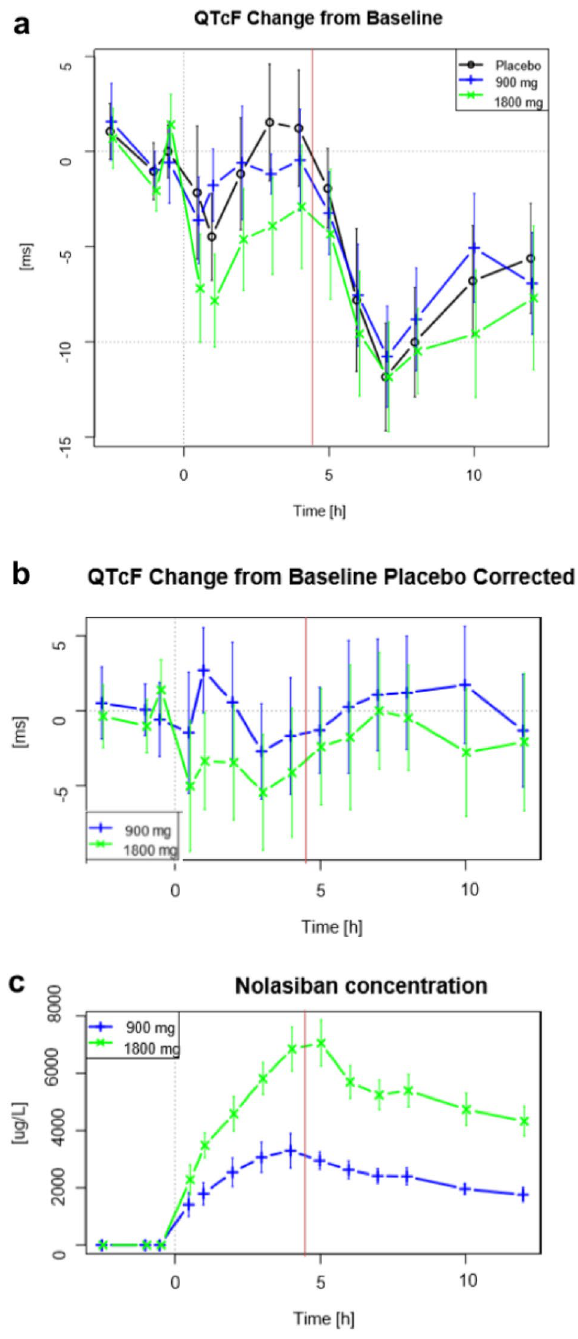
Figure 4. ( a ) Change from baseline QTcF, ( b ) Change from baseline QTcF—difference to placebo, ( c ) nolasiban concentration. Baseline is the average of mean values from pre-dose time points on Day 1. Plotted are mean values and 90% confidence intervals. The red line indicates provision of a meal, given 4.5 h post-dose.